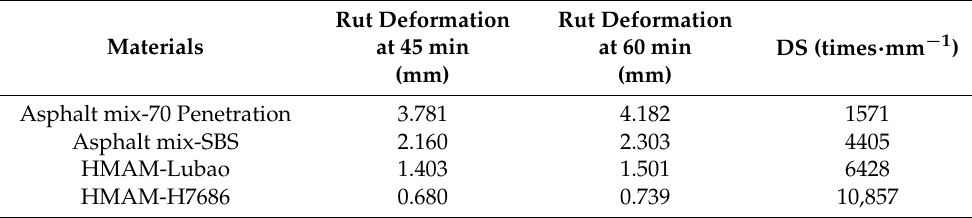
Table 7. The wheel tracking testing results.